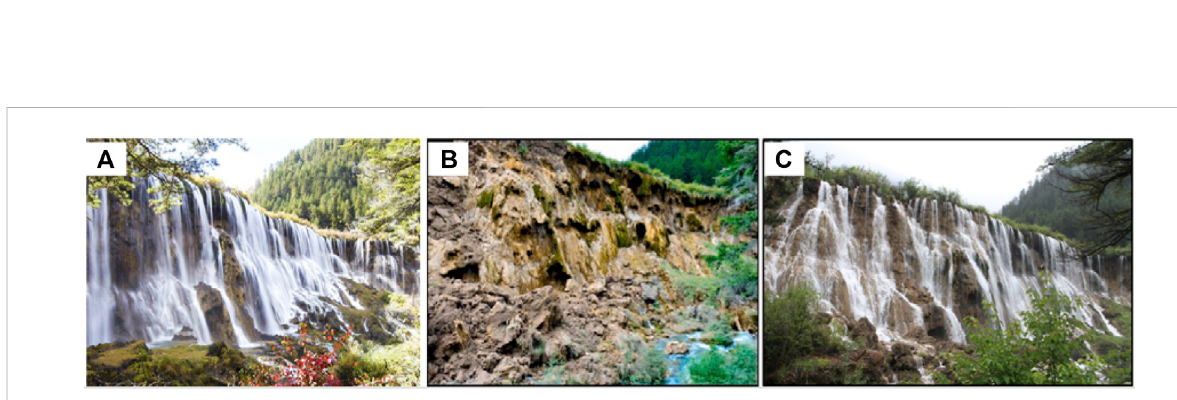
FIGURE 3 Nuorilang Waterfall in the Jiuzhai World Natural Heritage Site before (A) and after the 2017 earthquake (B) and after restoration (C) . Note: the image inpanel btaken from Zhanget al. (2021)shows that the waterfall dried up due to direct destruction of the connectivity betweentheupstream and downstream river systems; the photograph in panel c was taken in June 2020 by the